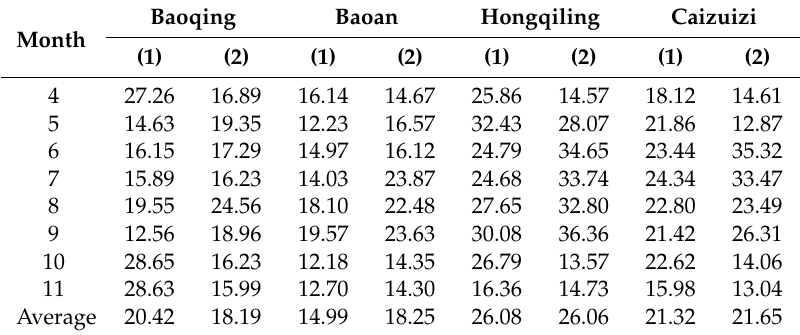
Table 4. Ecological water requirement damage frequency in each station (in